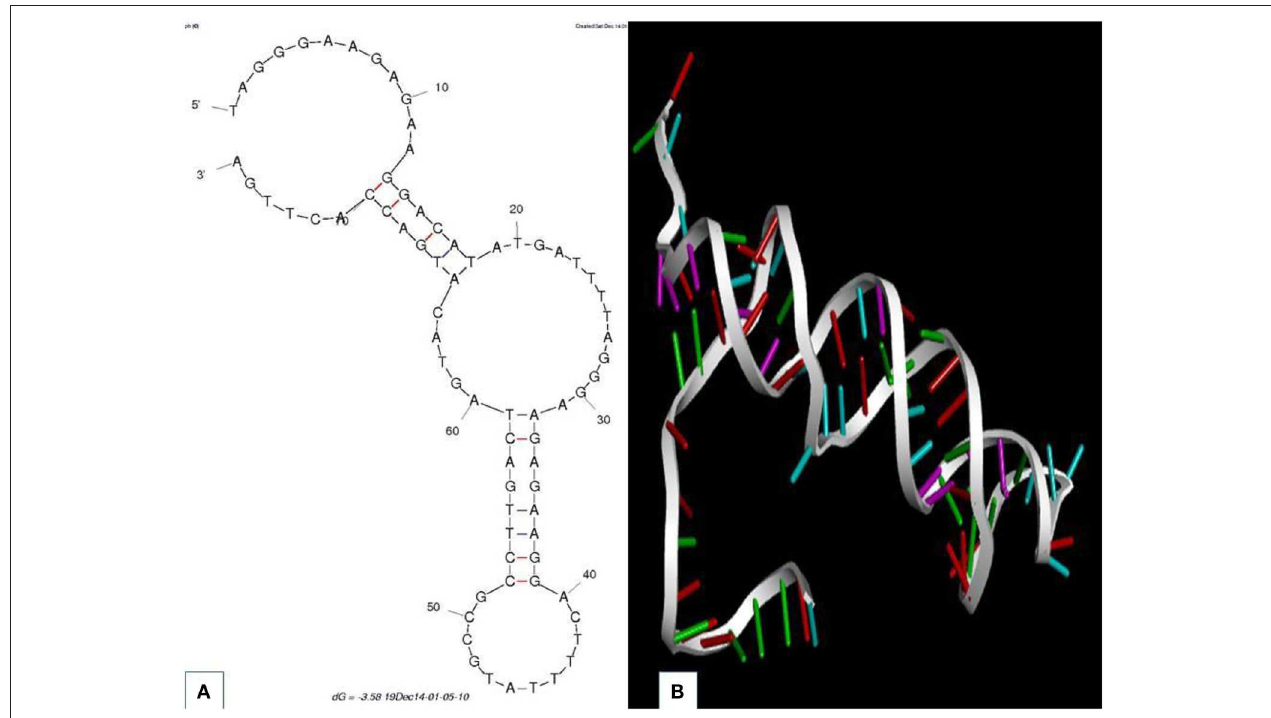
FIGURE 2 | Aptamer 2.26 (A) predicted secondary structure with the corresponding Gibbs free energy. (B) Tertiary